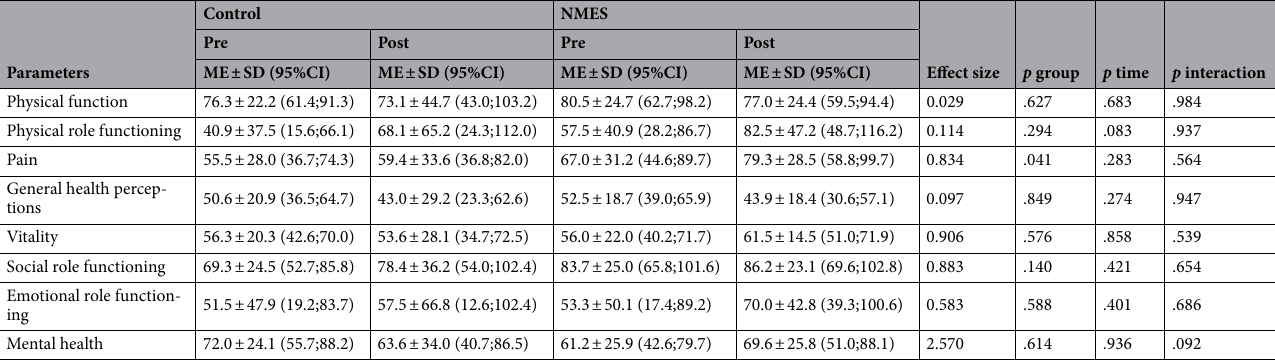
Table 2. Quality of life SF-36. ANOVA two-way (group × time interaction). ME Mean, SD Standard deviation, NMES Neuromuscular electrical